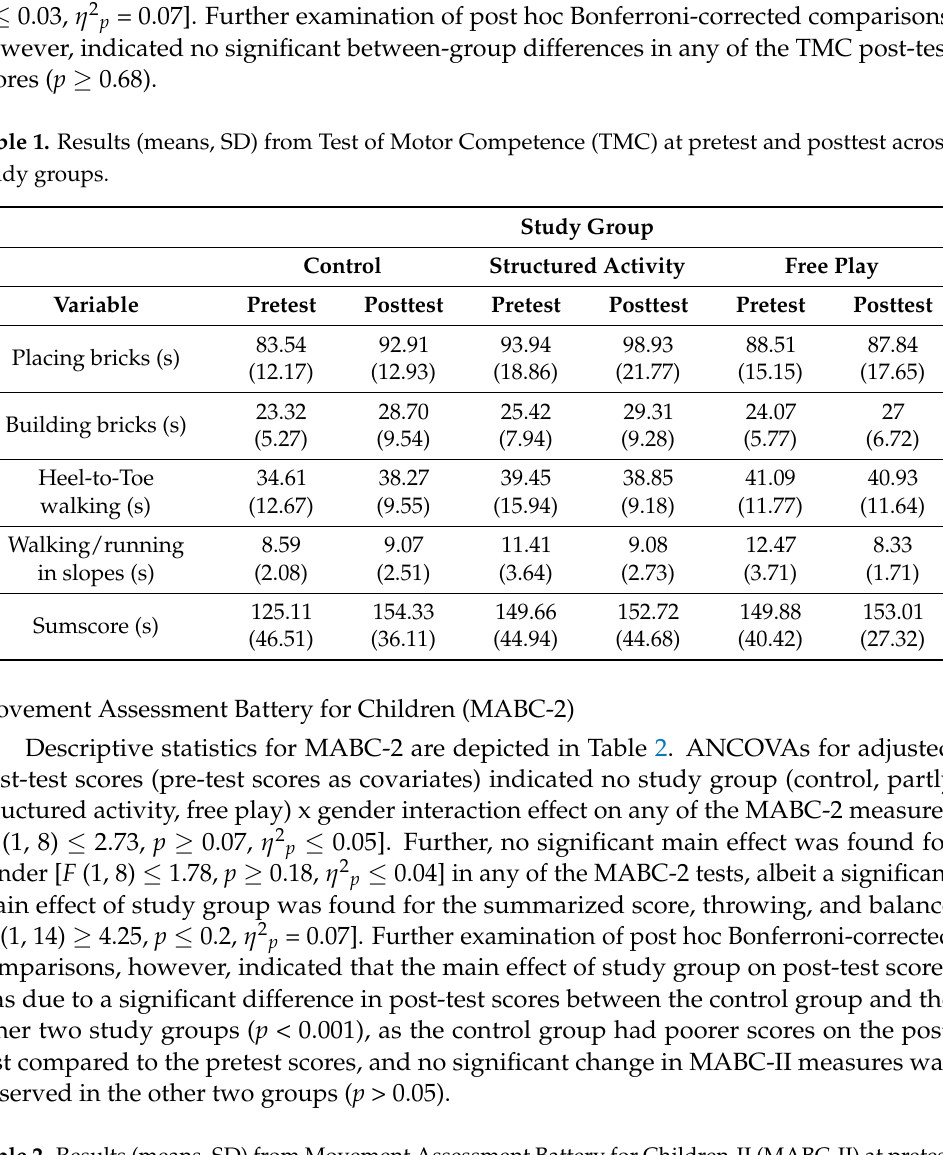
Table 2. Results (means, SD) from Movement Assessment Battery for Children-II (MABC-II) at pretest and posttest across study